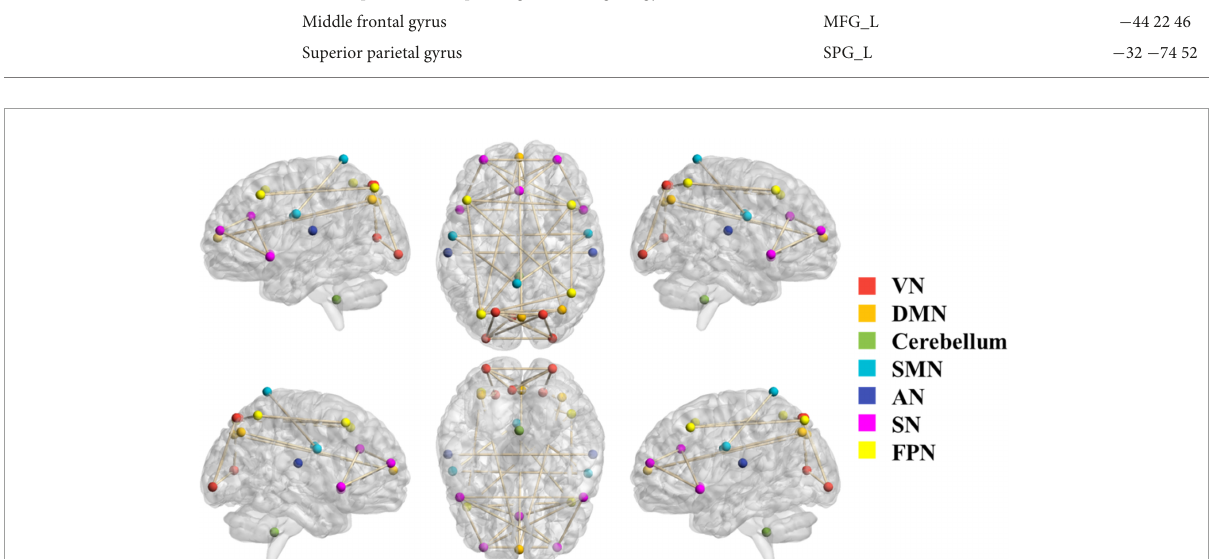
FIGURE2 The selected 24 ROIs correspond to 7 brain networks. The color of the node represents the brain network to which the node belongs. The ROIs of each brain network are connected by lines.